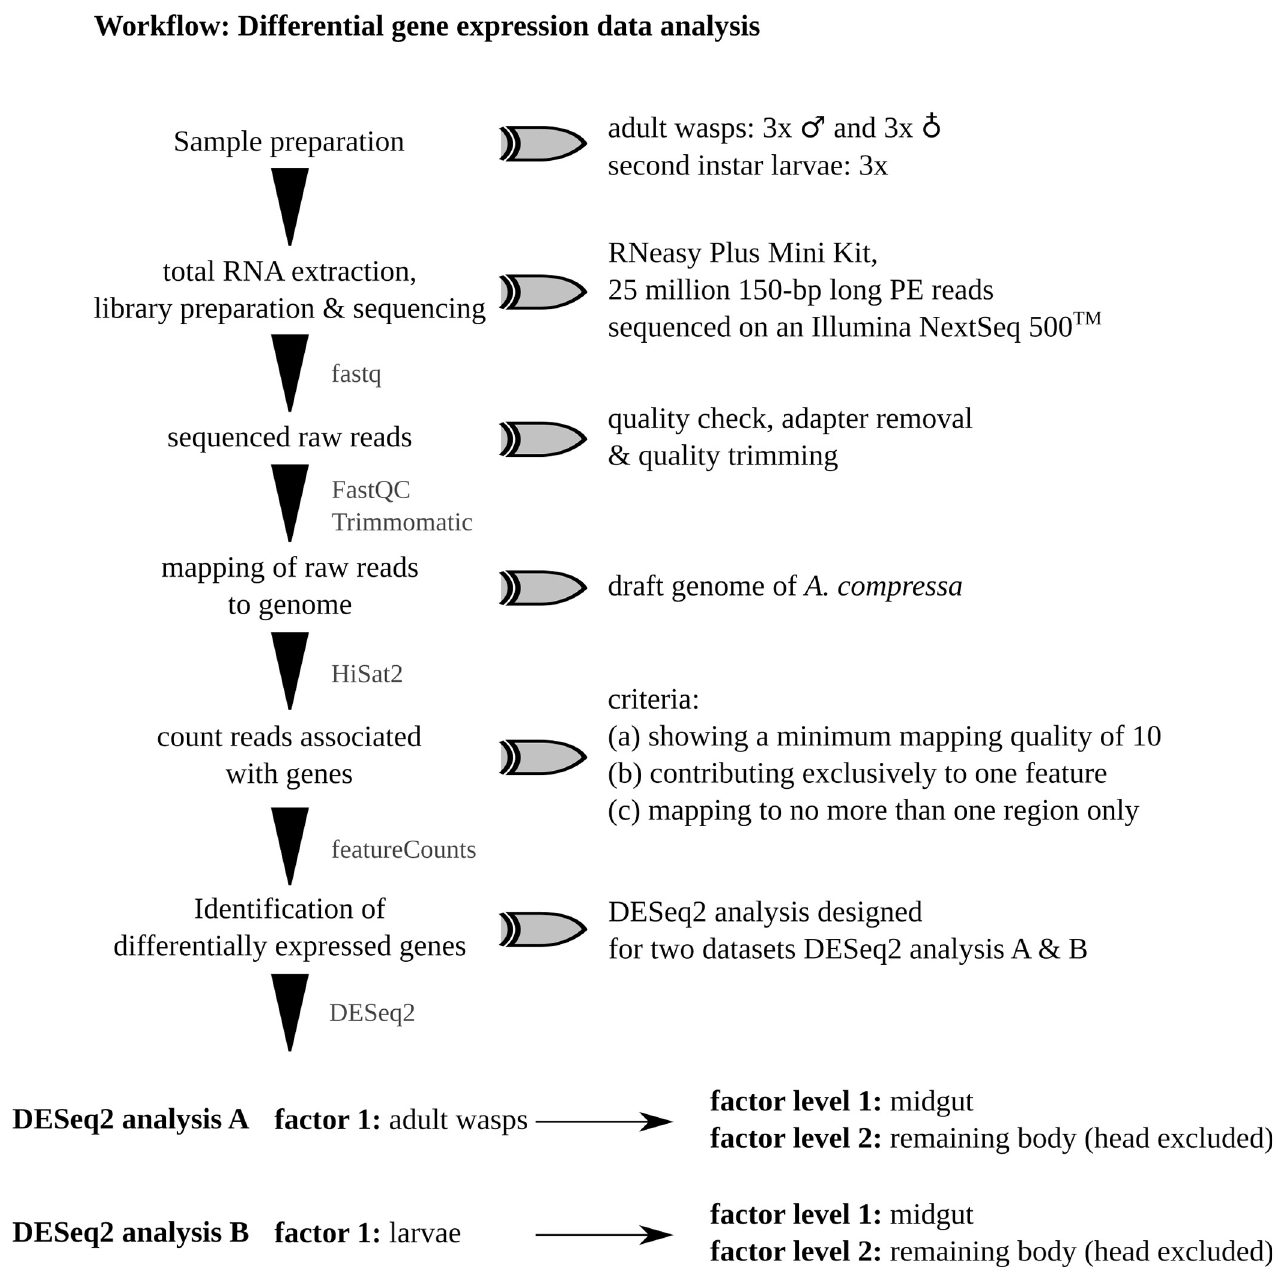
Fig 1. Schematic overview of the differential gene expression data analysis applied in this study. Sample preparation, RNA extraction, data checking and trimming, mapping and analysis of differential gene expression.